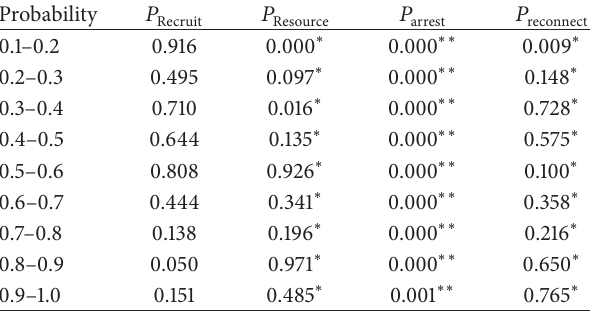
Table 4: Statistical significance of different